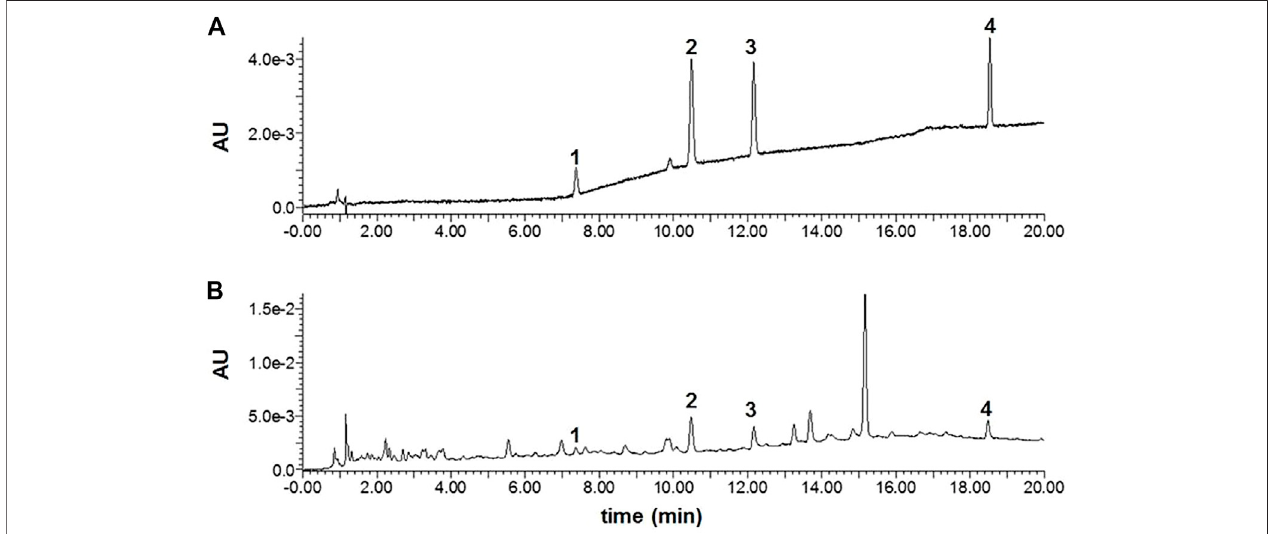
FIGURE 10| The UPLC-PDA chromatogramsof mixed standards (A) and the D101 fraction (B) . 1: rutin, 2: isochlorogenic acid A, 3: isochlorogenic acid C, and 4: darutoside.